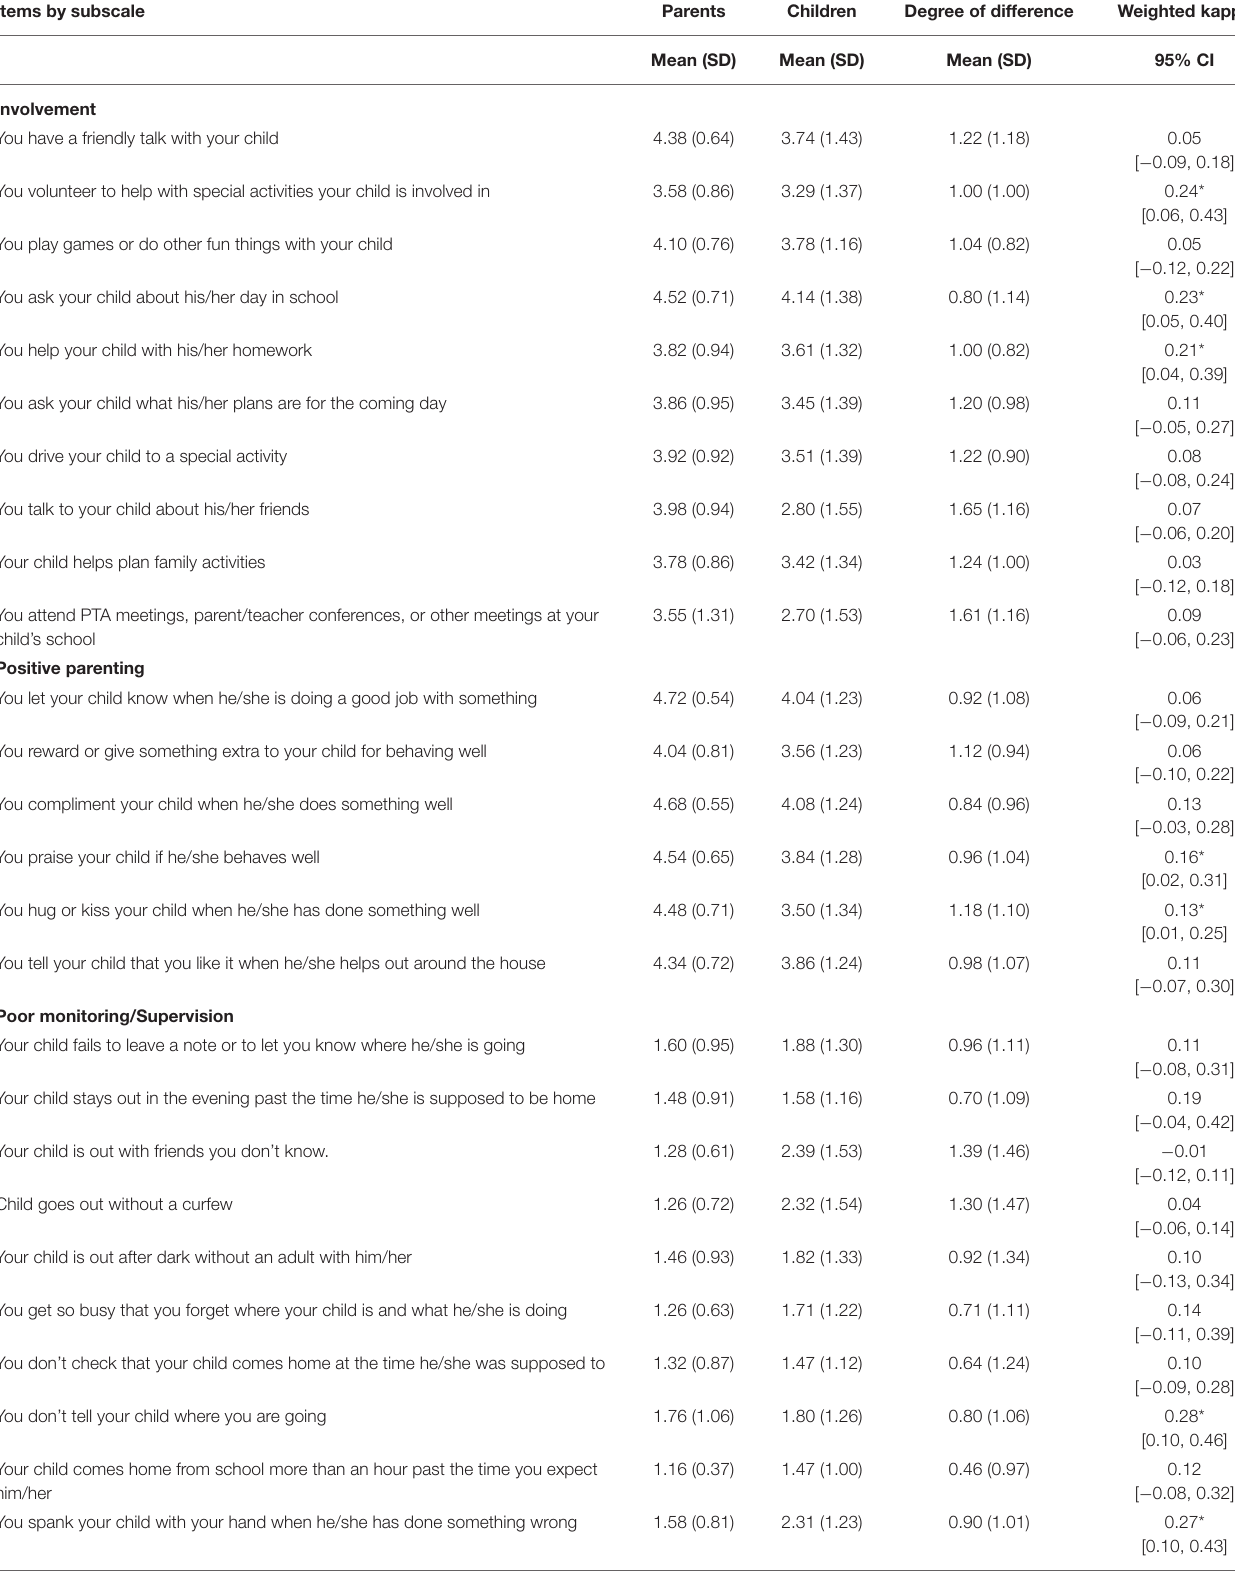
TABLE 2 | Agreement between parent and child reports on parenting at baseline as measured by the Alabama Parenting Questionnaire ( N = 50 dyads). Items by